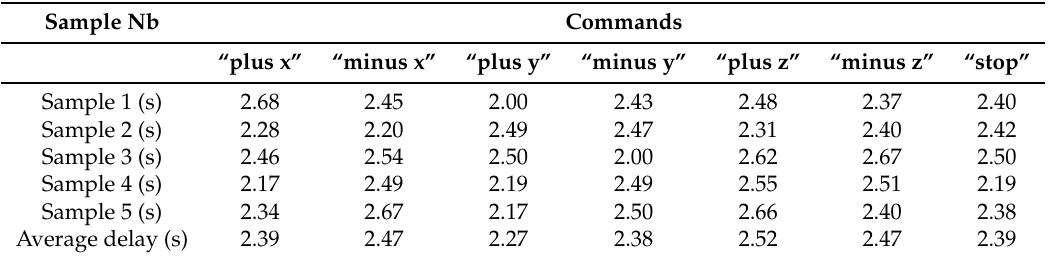
Table 3. Measurement of the delay of the robot’s reaction to the voice command: virtual station.